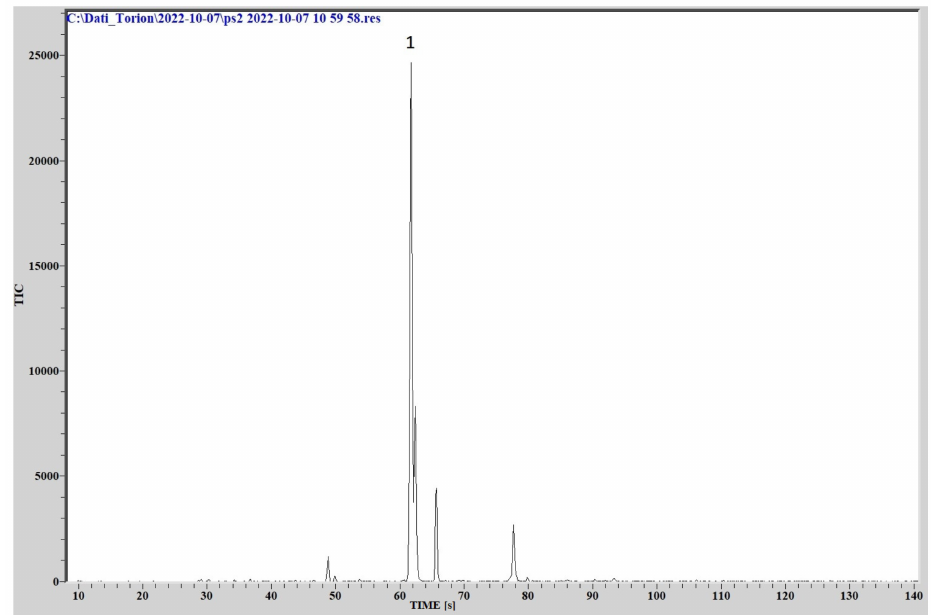
Figure 11. Chromatogram for P. aeruginosa. (1) 2-nonanone. As we can see, although identified compounds are numerically lower than those obtained with the common GC-MS, the obtained results are completely